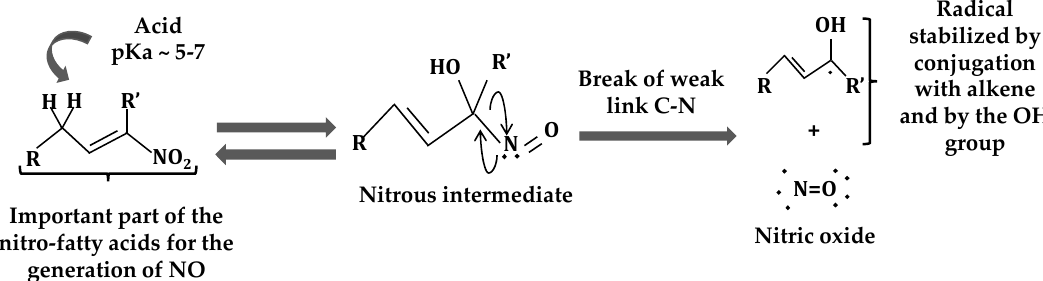
Figure 2. Mechanism of NO release through the modified Nef reaction. This mechanism consists of the generation of a nitrous intermediate which can homolyze in the aqueous medium to yield a carbon radical and nitric oxide (modified from Reference [62]).